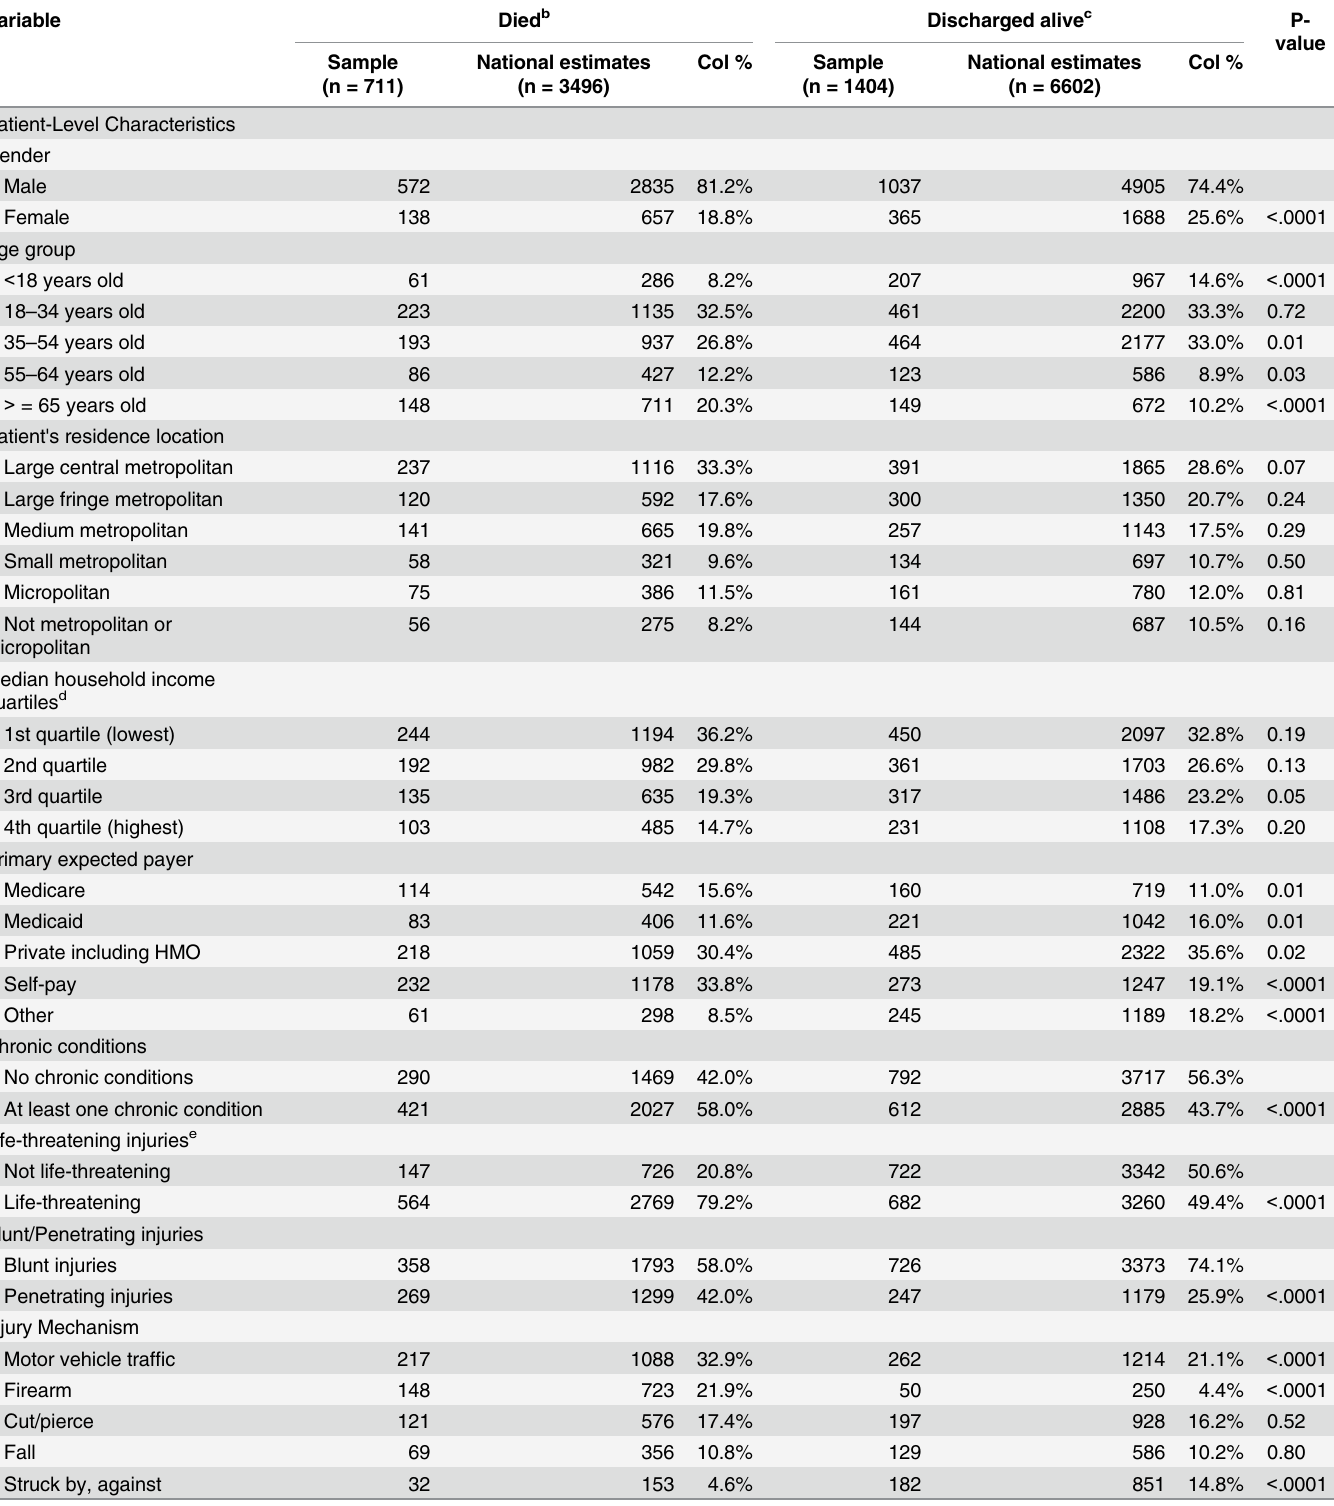
Table 3. Patient and hospital characteristics of patients with ISS 75 by mortality status, NEDS 2006 – 2010 a.